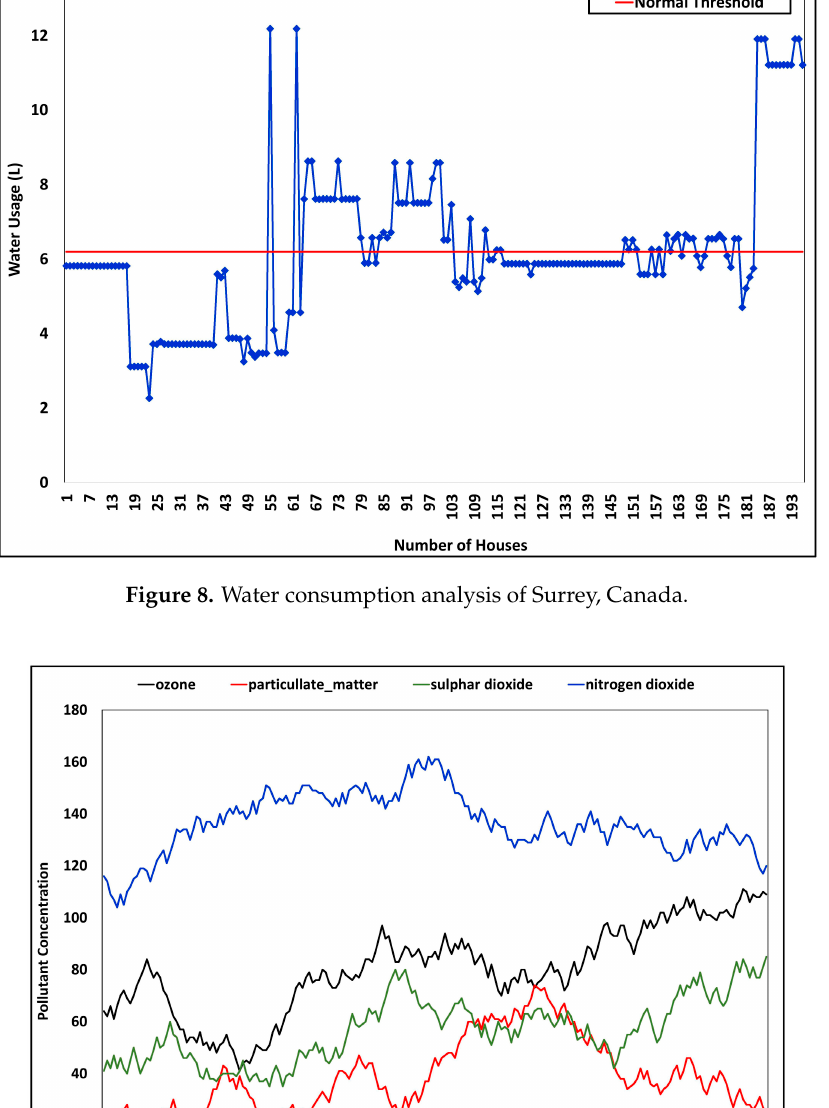
Figure 8. Water consumption analysis of Surrey, Canada.